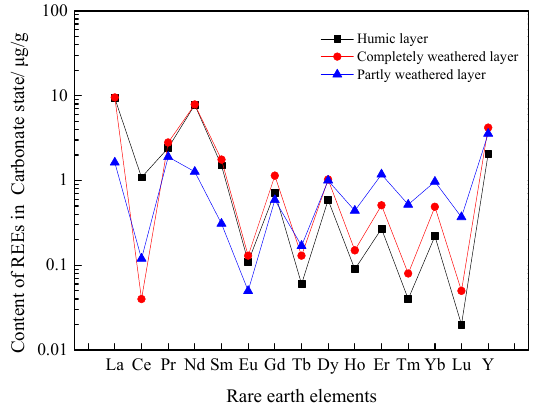
Figure 5. Rare earth contents of carbonate bound state.